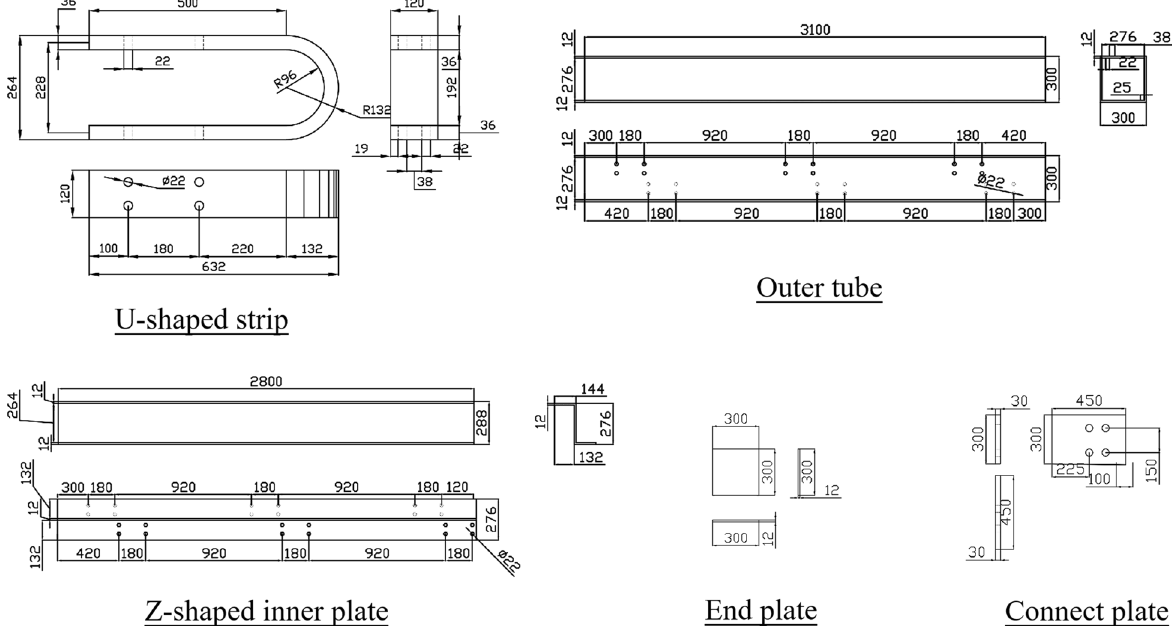
Fig. 18 Key dimensions of prototype brace (units in